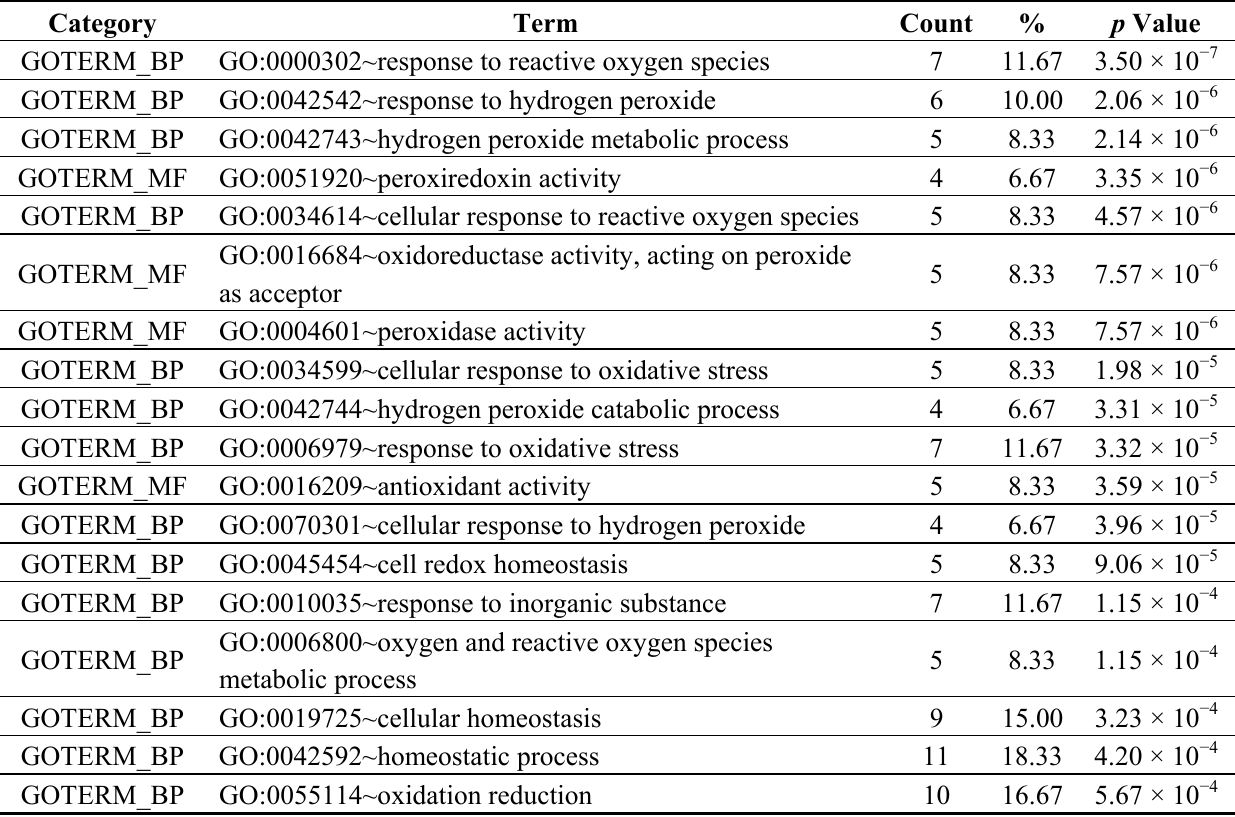
Table 2. Gene ontology analyses of succinated